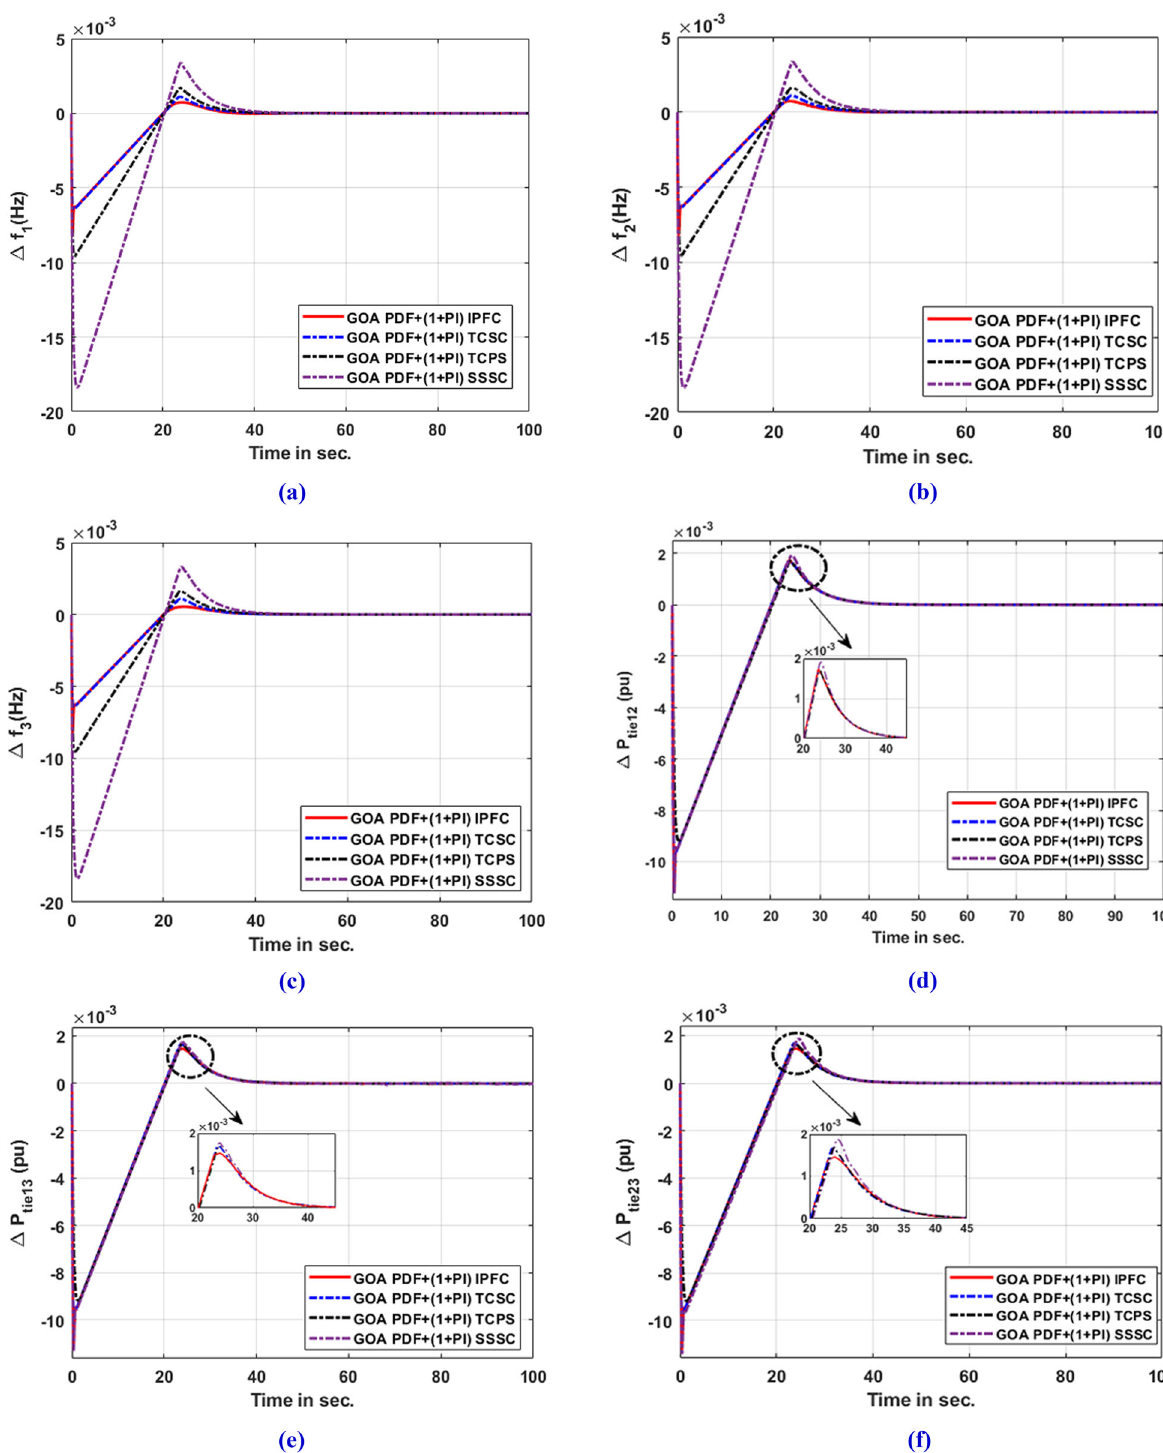
Fig. 9 Dynamic responses of FACTS devices with GOA optimized PDF+(1 + PI) controller and 1%